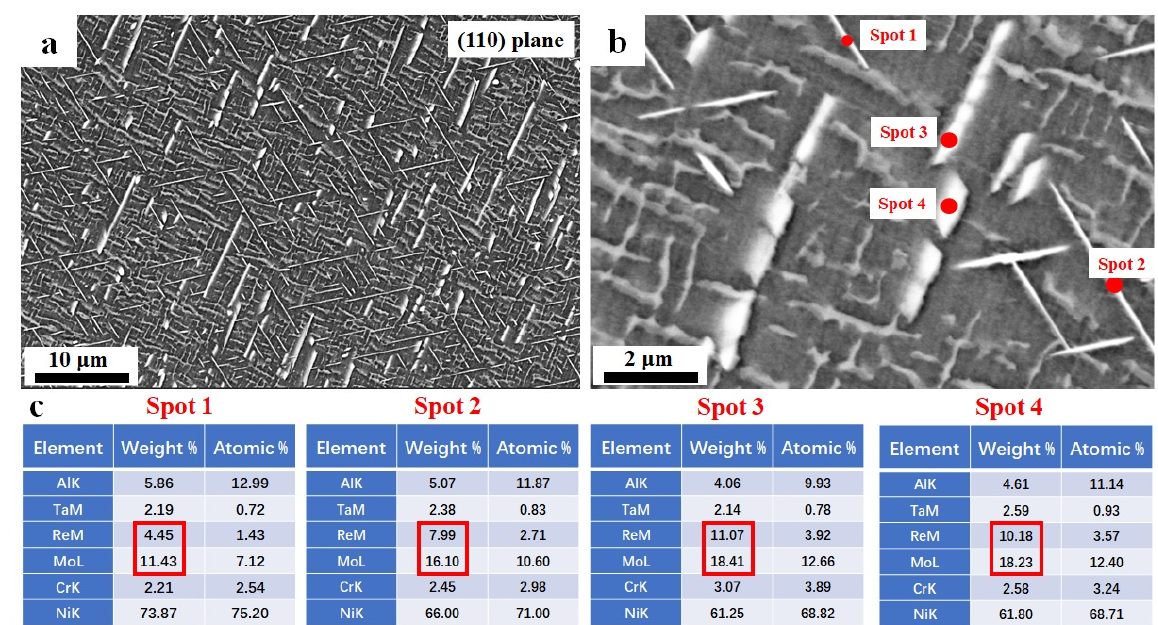
Figure 2. ( a ) Microstructure of Al–Mo–rich Ni–based SC superalloy after hot exposure; ( b ) enlarged image of ( a ); ( c ) EDS results of spot 1–spot 4 in ( b ).